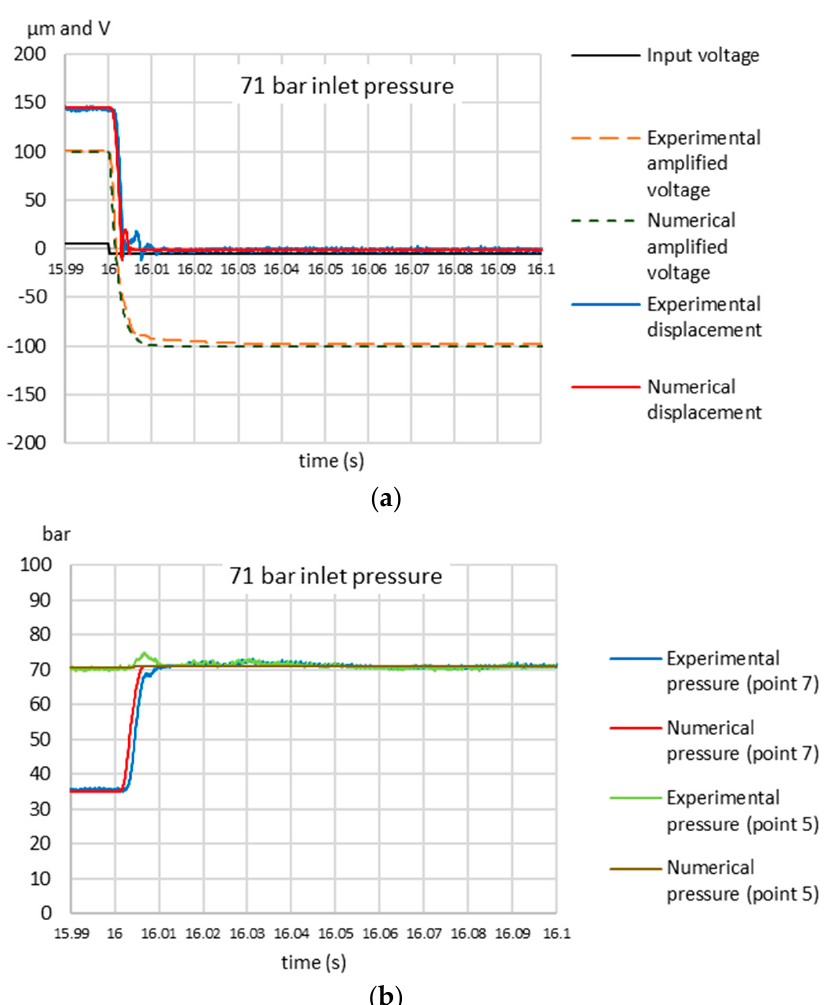
Figure 7. Test 3 (71 bar supply pressure). Comparison between measured amplified voltage and simulated one and between measured displacement and simulated one for a negative step control voltage (input voltage to the amplifier) from + 5 V to − 5 V: ( a ); comparison between measured pressures and simulated ones: ( b ) .